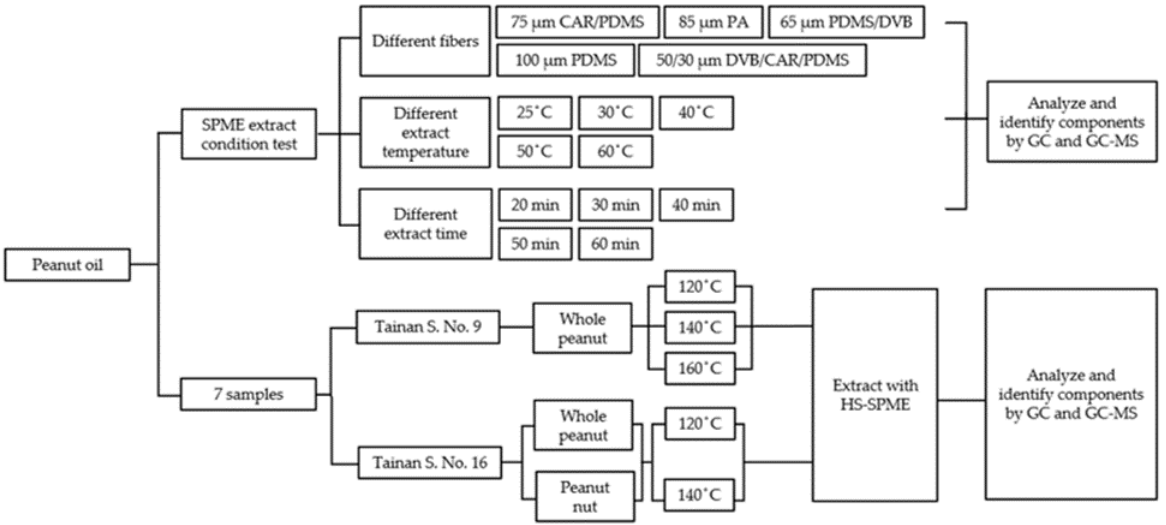
Figure 8. Flow diagrams of experiments performed to extract volatiles in peanut oils.